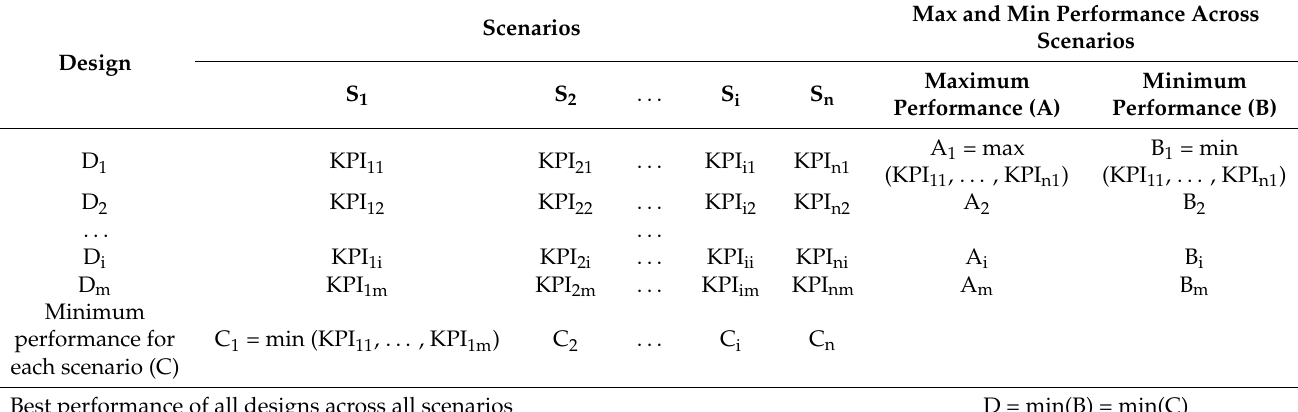
Table A1. Finding the maximum and minimum performance of a design across scenarios and best performance for designs and scenarios